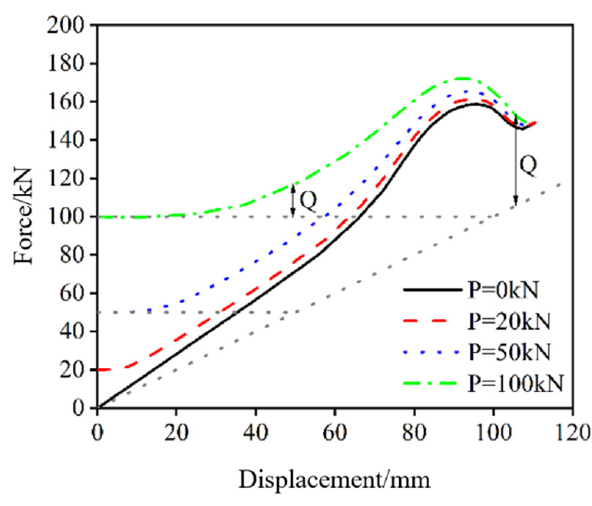
Figure 11. Load–displacement curve. Figure 12. Bolt force curve.